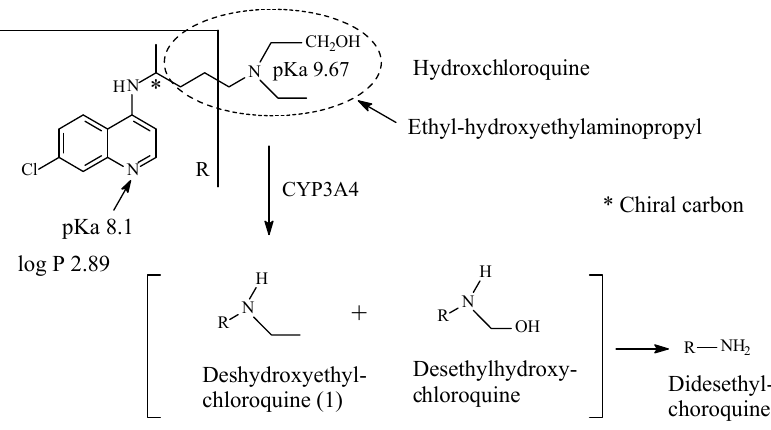
Figure 39. Metabolism of hydroxychloroquine.